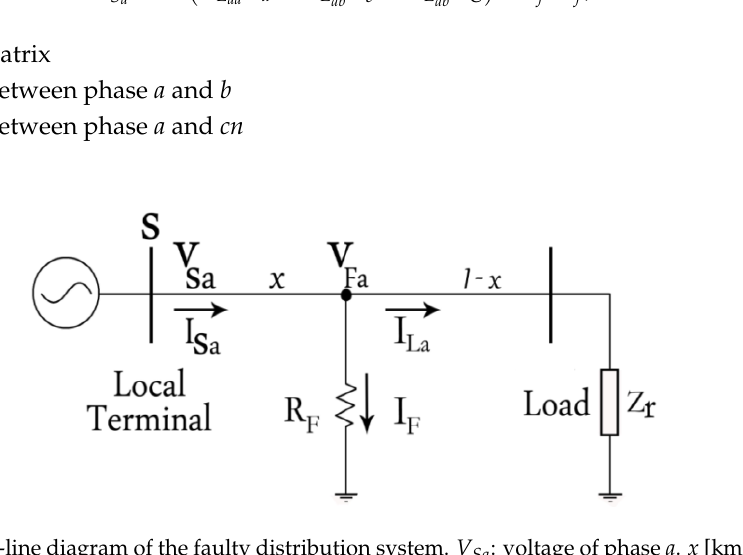
: impedance matrix (where Z line is line 𝑎𝑎 aa